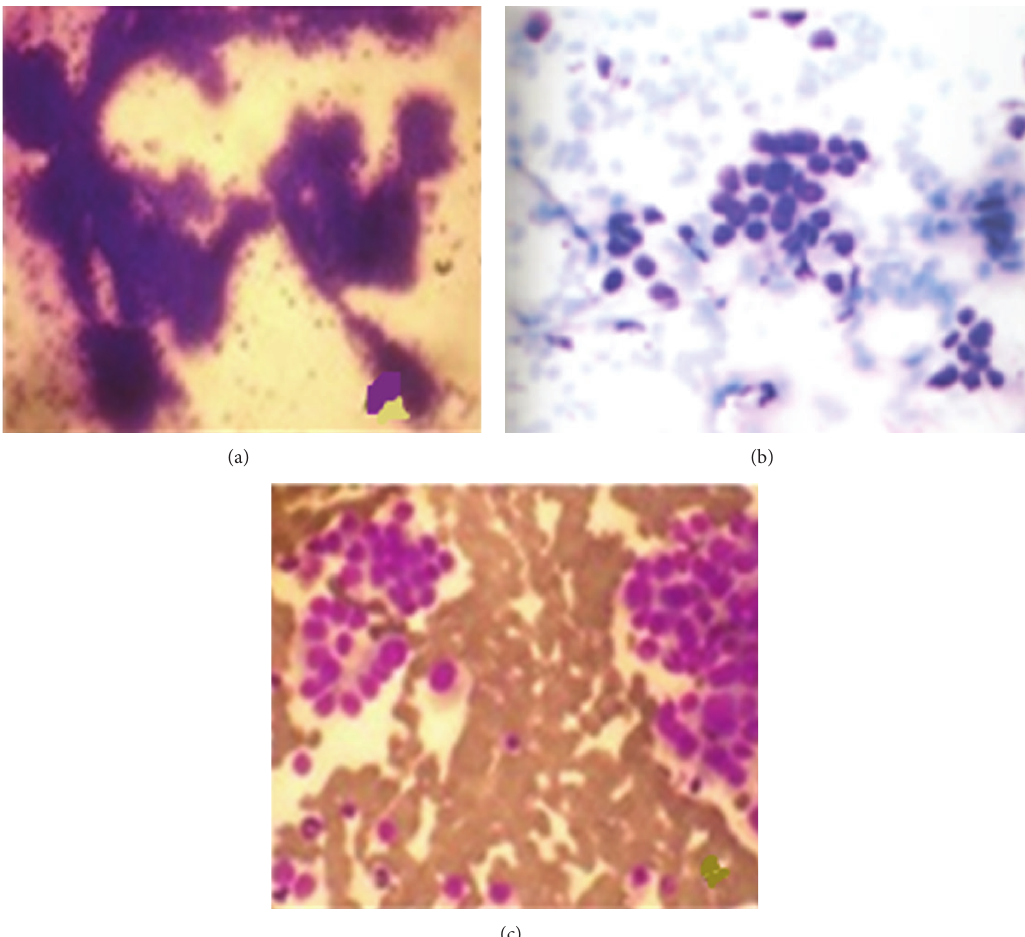
Figure 2: Cytomorphological findings in various metastatic lung lesions. (a) Metastasis of papillary fragments of adenocarcinoma arising from GIT [MGG × 200]. (b) Metastasis of squamous cell carcinoma arising from oral cavity [MGG × 400]. (c) Metastasis of follicular neoplasm thyroid [MGG ×